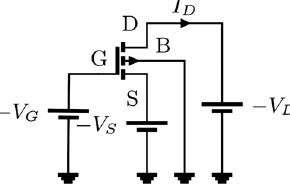
FIG. 4. Definition of voltage and current references for pMOS